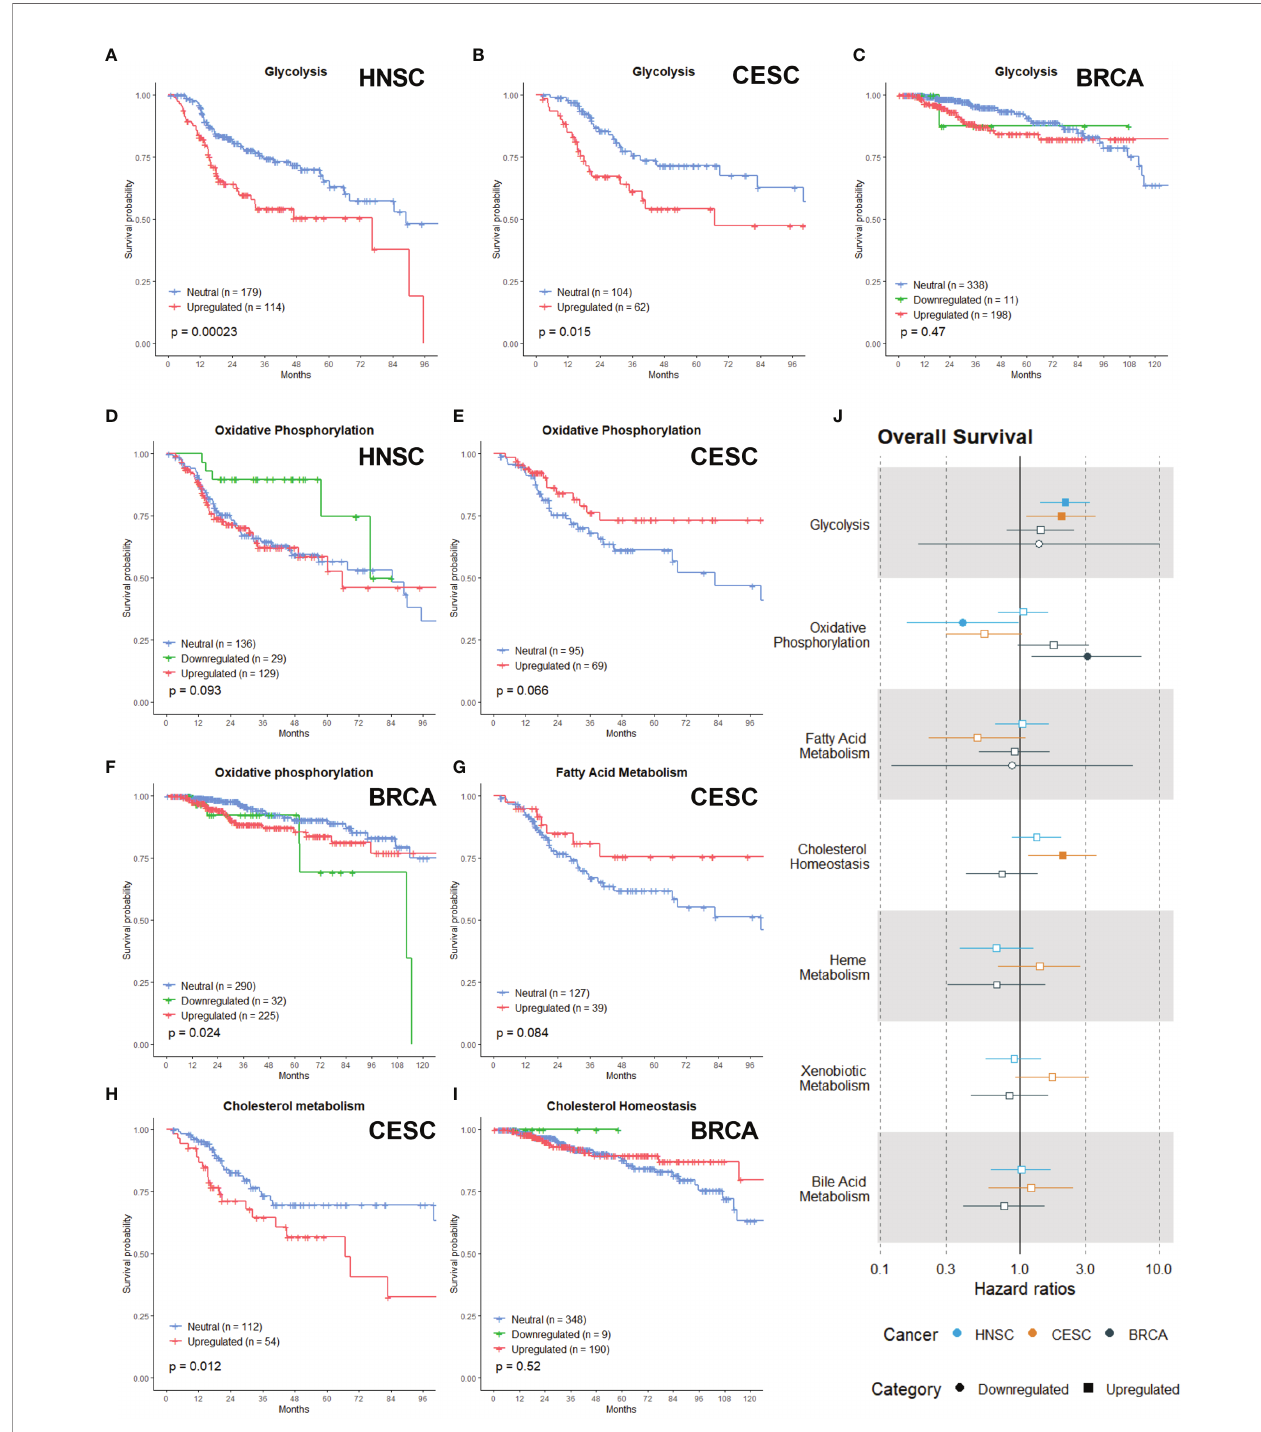
FIGURE 3 | Associations of gene sets of the Metabolism category with patient overall survival times. Kaplan-Meier plots for the Glycolysis gene set of (A) HNSC, (B) CESC and (C) BRCA patients associated with OS. Kaplan-Meier plots for the Oxidative Phosphorylation gene set of (D) HNSC patients, (E) CESC patients and (F) BRCA patients associated with OS. (G) Kaplan-Meier plot for the Fatty Acid gene set for CESC associated with OS. Kaplan-Meier plots for the Cholesterol gene set for (H) CESC patients and (I) BRCA patients associated with OS. (J) Forest plot showing the results from CoxPH model fi ts for OS of all the Metabolism category gene sets. Results for the HNSC patients are in blue, brown for the CSC patients and black for the BRCA patients. Upregulated gene sets are depicted with a □ symbol [closed ■ means these results are signi fi cant (p>0.05)]. Downregulated gene sets are depicted with a ○ symbol [closed ● means these results are signi fi cant